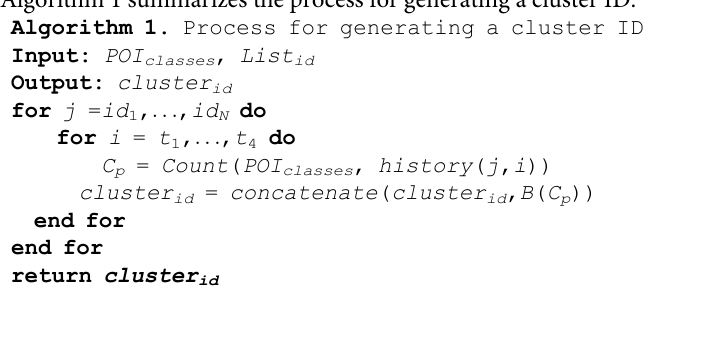
Algorithm 1. Process for generating a cluster ID